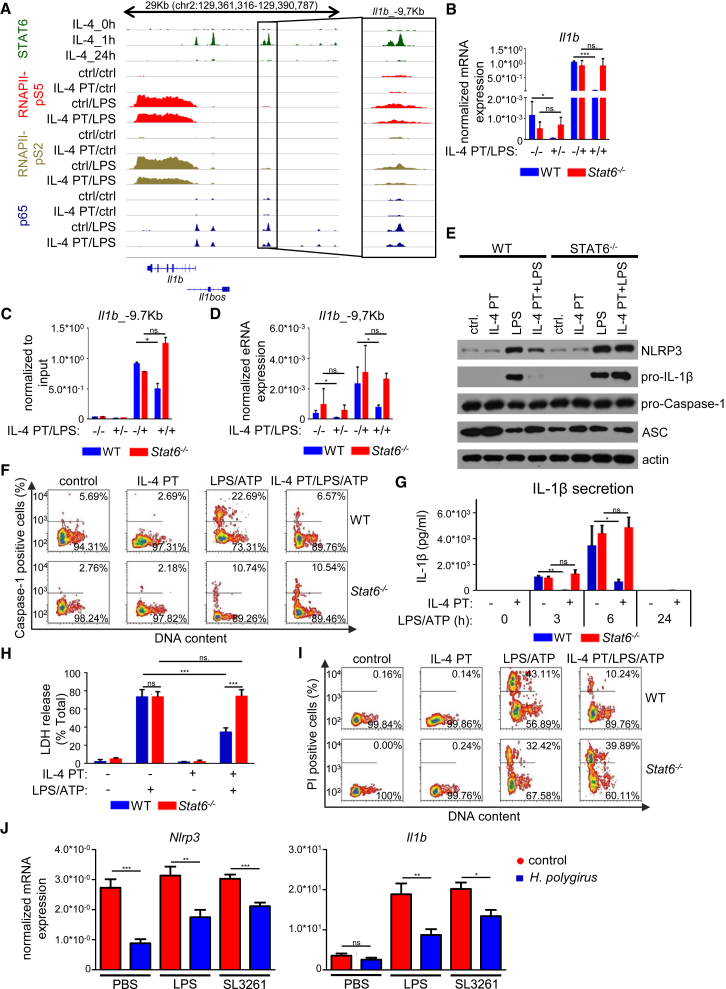
IL-4 Pretreatment Dampens the Inflammatory Response of Macrophages, Including Inflammasome Activation, IL-1β Production, and Pyroptosis(A) Genome browser view of STAT6-, RNAPII-pS5-, RNAPII-pS2-, and p65-specific ChIP-seq signals on the Il1b locus. Data are representative of two independent biological replicates.(B) RT-qPCR-based measurement of basal and LPS-induced Il1b expression in IL-4-pretreated and unstimulated WT and Stat6−/− BMDMs. Data are cumulative of four individual animals per genotype from two independent experiments. ∗p < 0.05, ∗∗p < 0.01, ∗∗∗p < 0.001, ns, no significant change. Error bars represent means ± SD.(C) ChIP-qPCR measurement of p65 binding at Il1b_−9.7Kb enhancer from WT and Stat6−/− BMDMs. Data represent the mean and SD of two biological replicates. +p < 0.1, ns, not significant change.(D) RT-qPCR measurement of basal and LPS-induced Il1b_−9.7Kb eRNA expression in IL-4-pretreated and unstimulated WT and Stat6−/− BMDMs. Data are cumulative of four individual animals per genotype from two independent experiments. ∗p < 0.05, ∗∗p < 0.01, ∗∗∗p < 0.001, ns, not significant change. Error bars represent means ± SD.(E) Western blot determination of basal and LPS-regulated Nlrp3, pro-IL-1β, pro-Caspase1, ASC, and β-actin expression in IL-4-pretreated and unstimulated WT and Stat6−/− BMDMs. Data are representative of five individual animals per genotype from two independent experiments.(F) Contour map representation of laser-scanning imaging cytometry of Caspase-1 activity in WT and Stat6−/− BMDMs. Data are representative of two independent experiments.(G) ELISA measurement of IL-1β secretion in IL-4-pretreated and unstimulated WT and Stat6−/− mouse BMDMs. Data represent the mean and SD of three individual animals. ∗p < 0.05, ∗∗p < 0.01, ∗∗∗p < 0.001, ns, no significant change.(H) Lactate dehydrogenase activity assay measurement of LPS and ATP co-stimulation-induced LDH release in IL-4-pretreated and unstimulated WT and Stat6−/− BMDM supernatants. LDH release expressed as the percentage of Triton X-100-liberated total LDH release. Data represent the mean and SD of three individual animals. ∗p < 0.05, ∗∗p < 0.01, ∗∗∗p < 0.001, ns, no significant change.(I) Contour map representation of laser-scanning imaging cytometry analysis of PI-labeled WT and Stat6−/− BMDMs. Data are representative of two independent experiments.(J) Basal, LPS, and Salmonella Typhimurium (SL3261)-induced expression of Nlrp3 and Il1b expression in naive and Heligmosomoides polygyrus (H. polygyrus)-infected mice-derived peritoneal macrophages. Each data point represents the mean and SD of five to six individual animals per group. ∗p < 0.05, ∗∗p < 0.01, ∗∗∗p < 0.001, ns, no significant change.BMDMs were pretreated with IL-4 for 24 hr followed by LPS exposure for 1 hr (A and C), 3 hr (B, D, E, F, H, and I), or the indicated period (G).